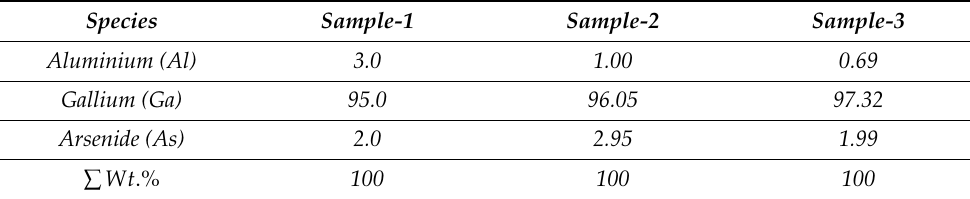
Table 1. Certified compositions (%) of Al, Ga and As present in the three AlGaAs samples. Species Sample-1 Sample-2